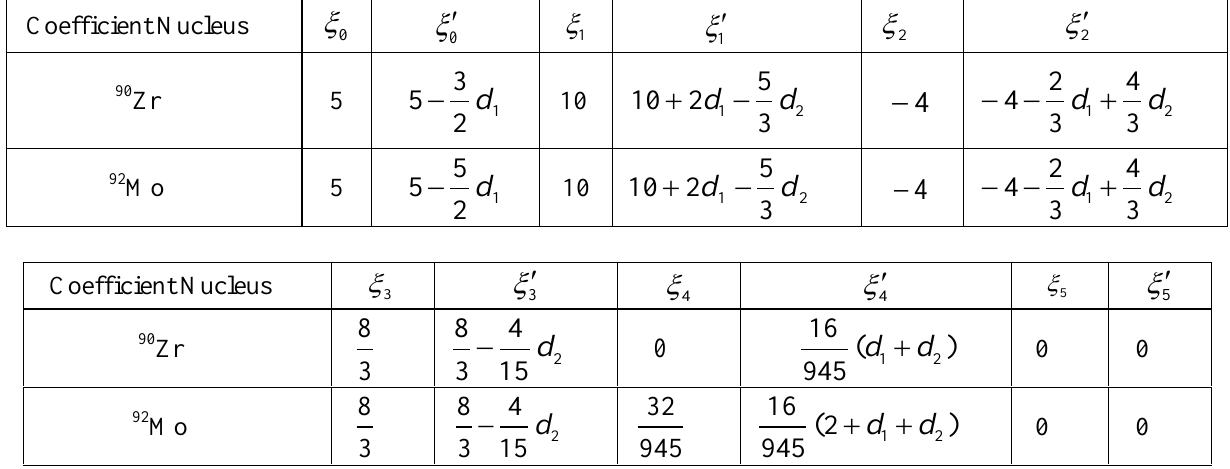
Table1: Coefficients of the charge density of nuclei in the simple ( )  shell ( ) m